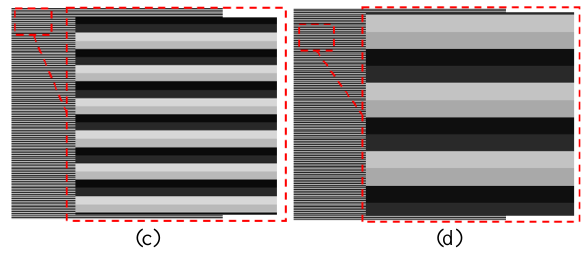
Figure 6. (a) (b) (c) (d) are the interference patterns when 1  = and  is 1, 0.9, 0.8, 0.7 respectively. s p